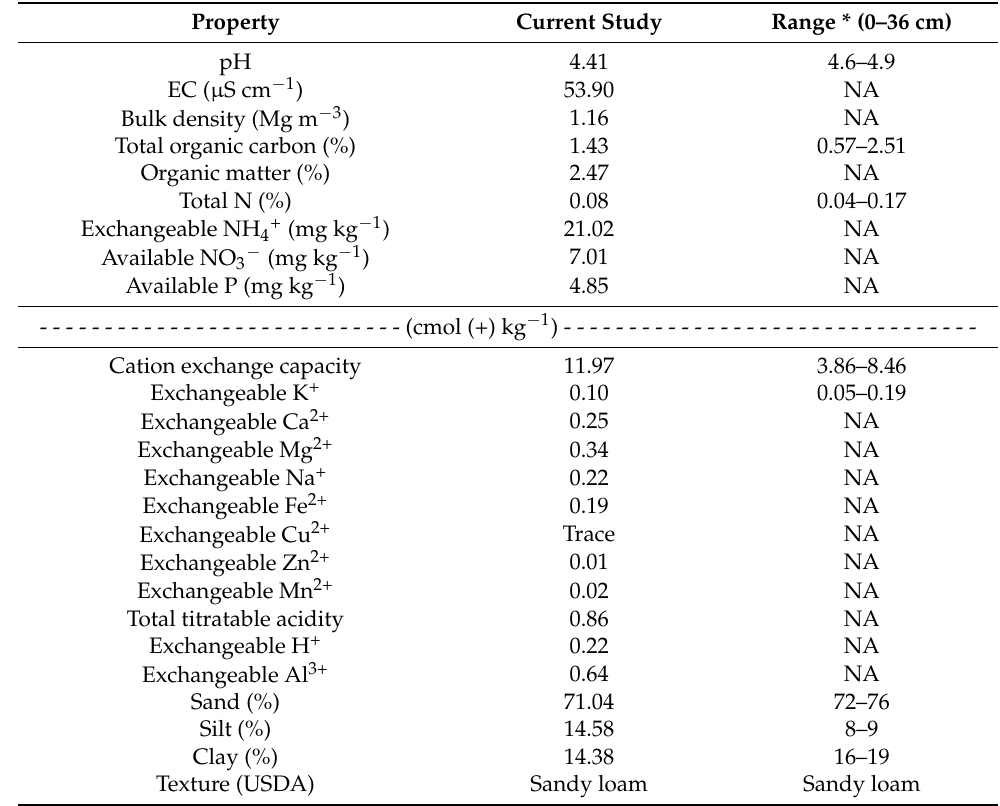
Table 1. Physico-chemical characteristics of the soil used in the sorption studies.